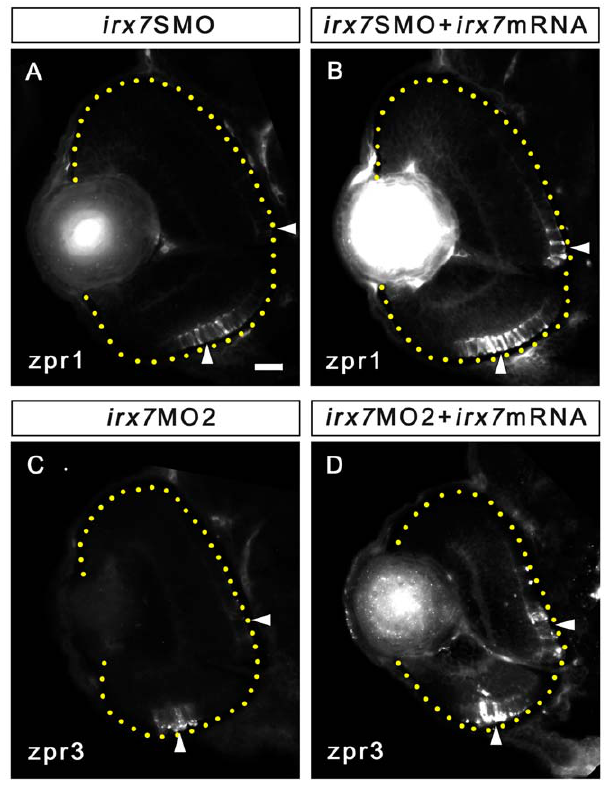
Figure 10. Irx7 mRNA can partially rescue the effects caused by Irx7 knockdown. (A and B) Immunostaining of anti-zpr1 for cones on the retinal section of an morphant and a rescued embryo at 72 hpf respectively. (C and D) Immunostaining of anti-zpr3 for rods on the retinal section of an irx7 MO2 morphant and a rescued embryo at 72 hpf respectively. Lateral is to the left and dorsal is up for all sections. The retinal region in the samples is highlighted by a dotted yellow line. The comparable regions in the retinas are highlighted by white arrowheads. Scale bar=20 m m.